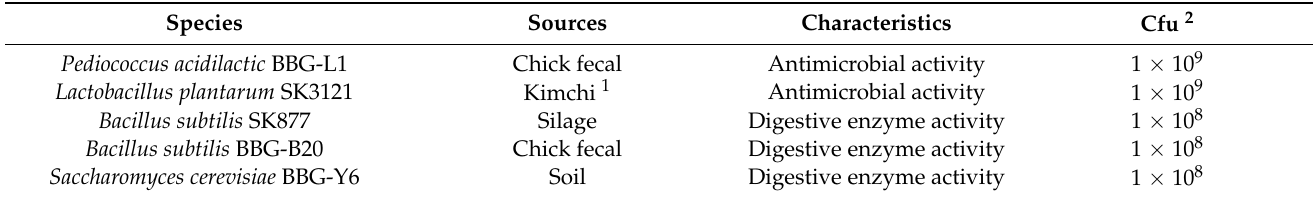
Table 1. Isolation sources, characteristics, and microbial counts of the additives in the present study. Species Sources